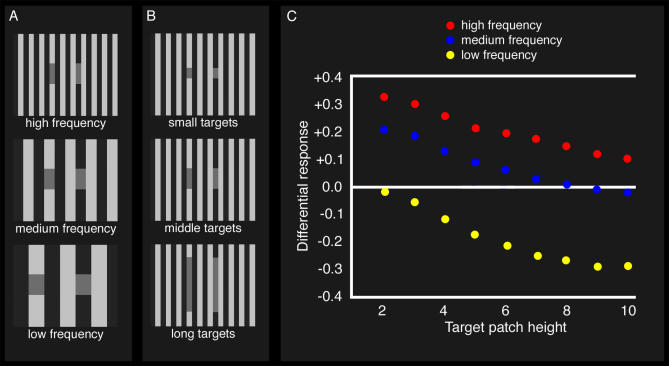
White's Stimuli and ANN Responses(A) Three White's stimuli of varying spatial frequency and (B) three White's stimuli with different target patch heights. In all cases, the left-hand target patch has the same intensity as the right-hand patch, but generally appears darker to humans. The stimuli seen by the ANNs are 20 × 20 pixels.(C) Mean ANN responses to White's stimuli of varying frequencies with varying test patch heights. Each value is the difference in predicted reflectance for the two test patches. A positive difference means that the test patch on the light bar appears darker than the test patch on the dark bar; a negative difference means the test patch on the light bar appears lighter than the patch on the dark bar. The former is consistent with White's illusion, the latter with brightness contrast. The results show i) that decreasing the frequency of the background stripes (i.e., making them wider) also decreases the strength of White's illusion; and also ii) that increasing the height of the test patch decreases the strength of White's illusion. Both results correspond to human psychophysical responses [5].